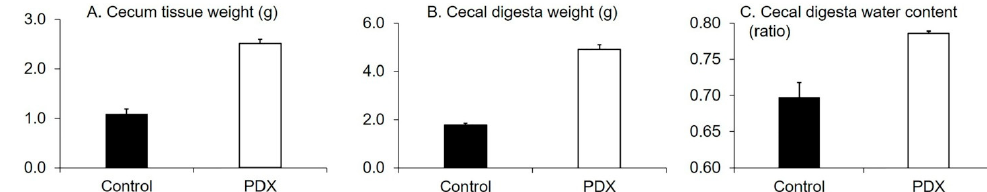
Figure 1. Effects of polydextrose (PDX) addition on the cecum tissue weight ( A ), cecal digesta weight ( B ), and cecal digesta water content ( C ). n = 6 per group. Data are expressed as means (histogram bars) and SEM (error bars). Cecum tissue weight, cecal digesta weight, and cecal digesta water content in the PDX group were higher than those in the control group ( p < 0.0001, 0.0001, and p = 0.007, respectively, Welch’s t -test).